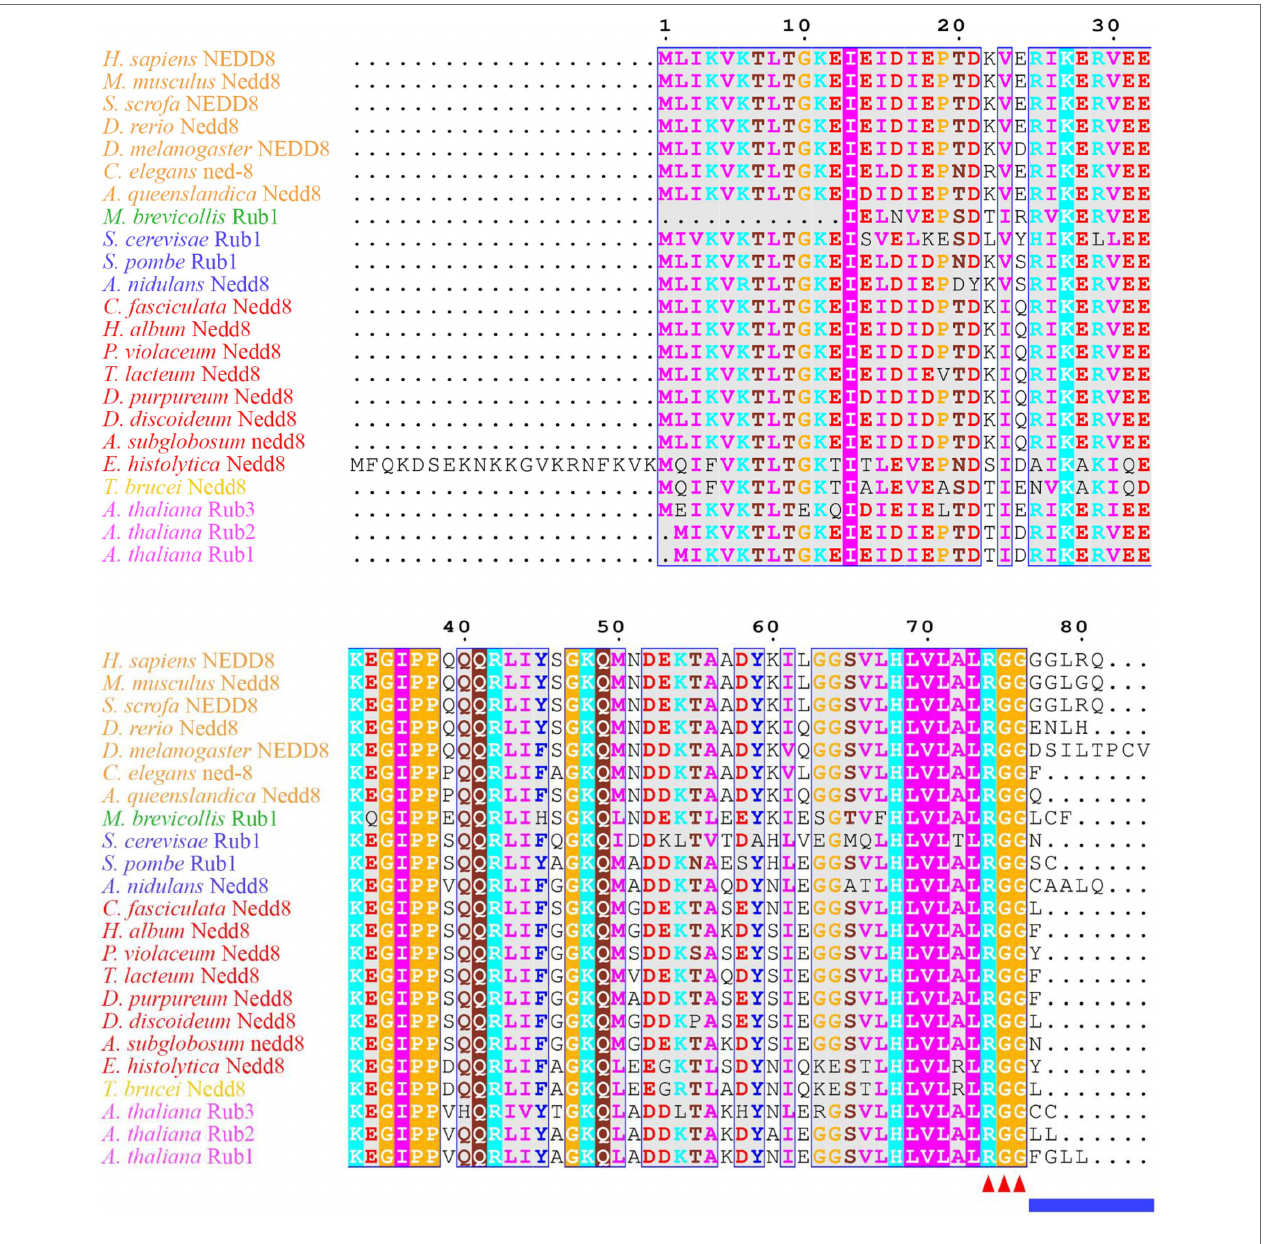
FIGURE 1 | Neural precursor cell expressed developmentally downregulated protein 8 (NEDD8) is conserved across eukaryotes. Alignment of NEDD8 ortholog protein sequences in different eukaryote species, including those in plants (pink), amoebozoa (red), fungi (blue), and animals (orange). For plants, the upstream ubiquitin sequence was trimmed from the NEDD8 orthologs. Sequences were aligned on MEGA7 using the MUSCLE alignment and displayed using ESPript 3.0. Colored residues indicate physiochemical properties and conservation at a position. The C-terminal “RGG” proteolytic processing motif is marked by red arrowheads and the NEDD8 overhang sequence that is cleaved is indicated by the blue